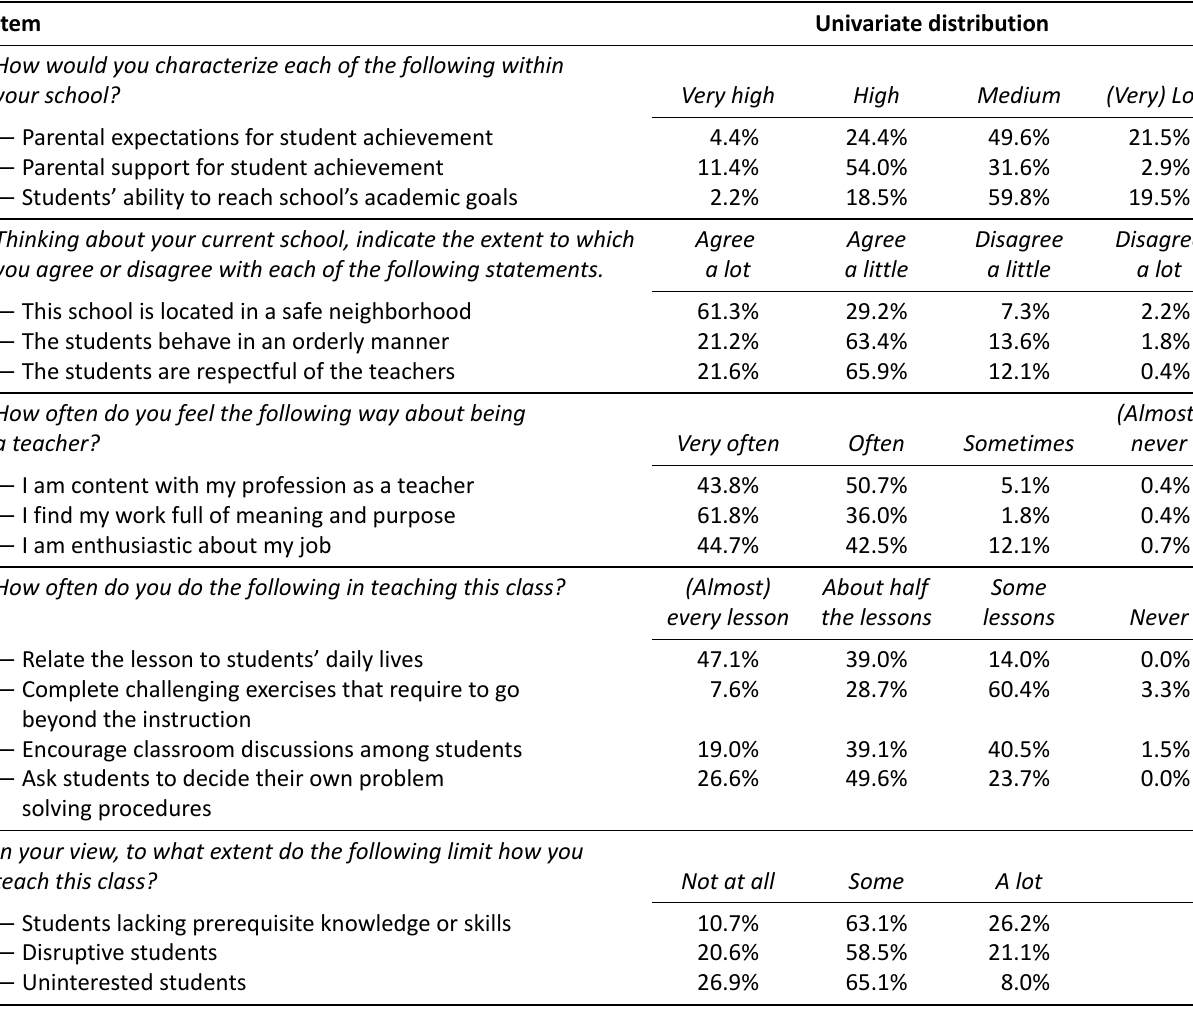
Table 1. Items used for